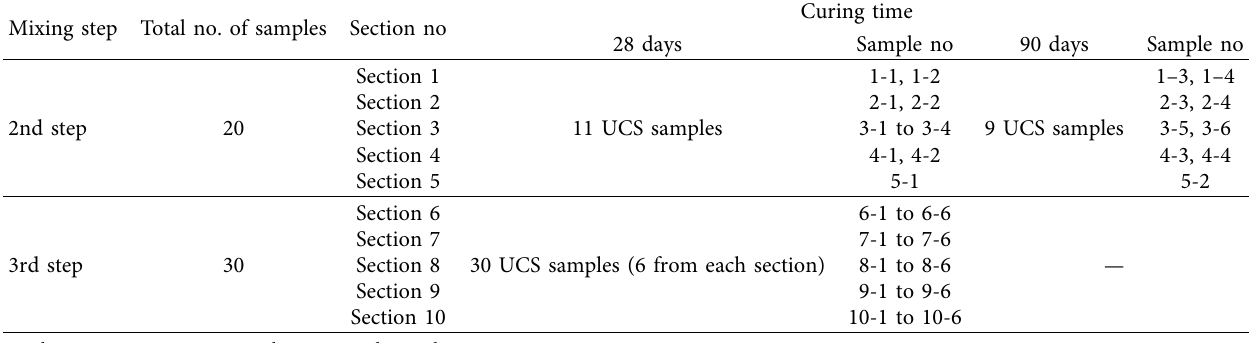
Table 2: Number of samples from the frst phase.